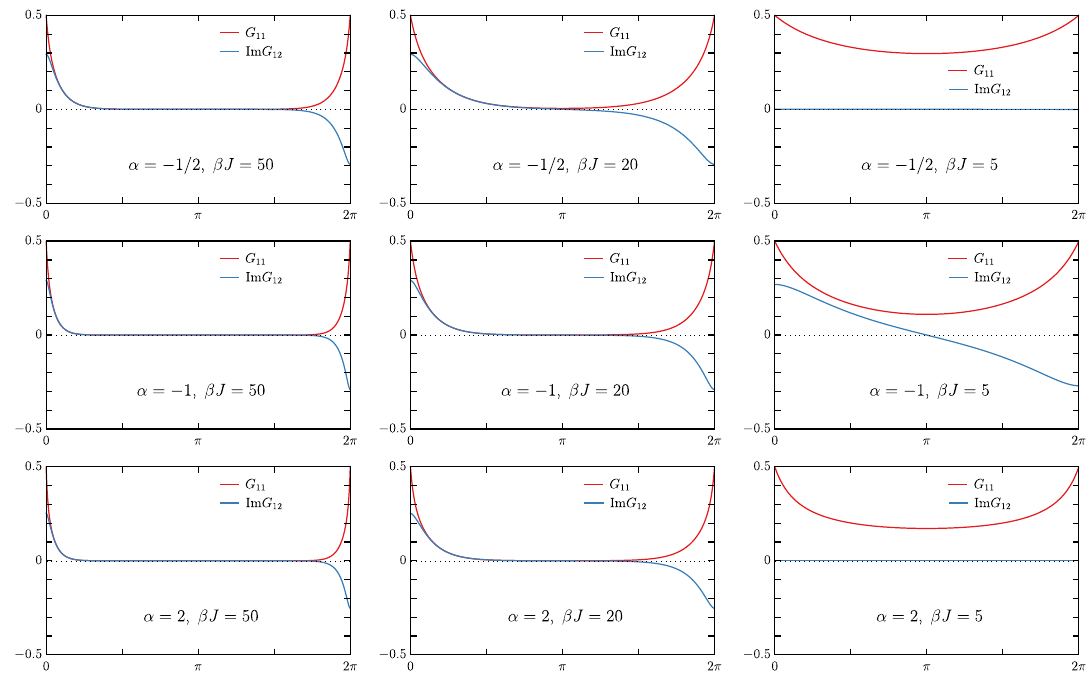
Figure 2 . Numerical solutions to the DS equations for different values of α and βJ , plotted against θ = 2 πτ . All the values of α shown lie in the range where U(1) − is spontaneously broken at large β βJ . We note that all correlators exponentially decay at the same